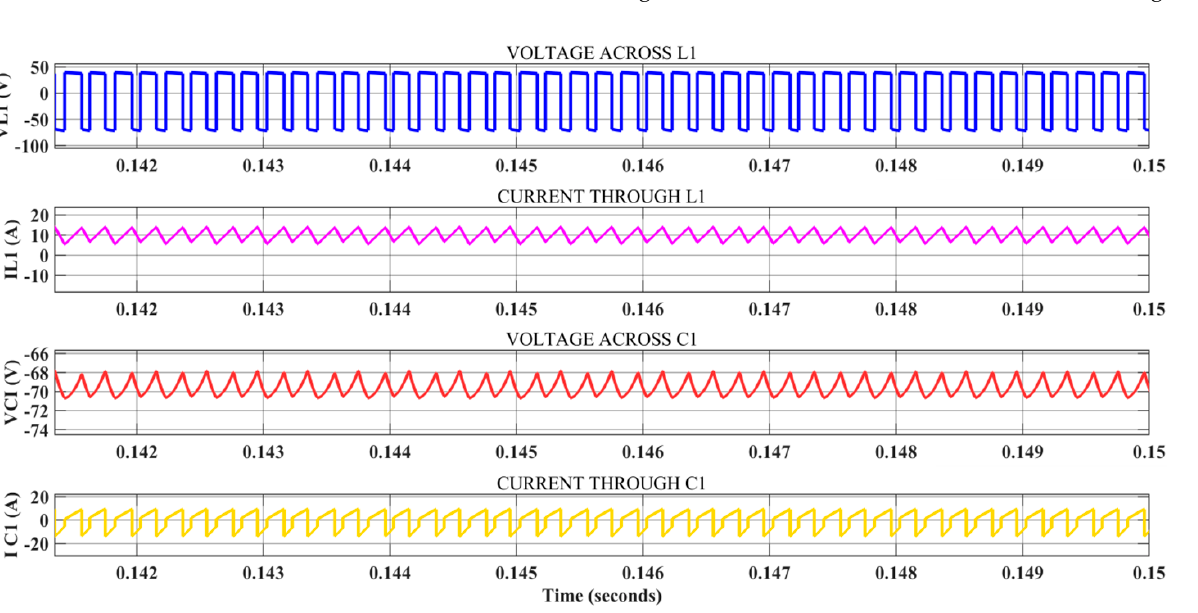
the current through the inductor L 0 .